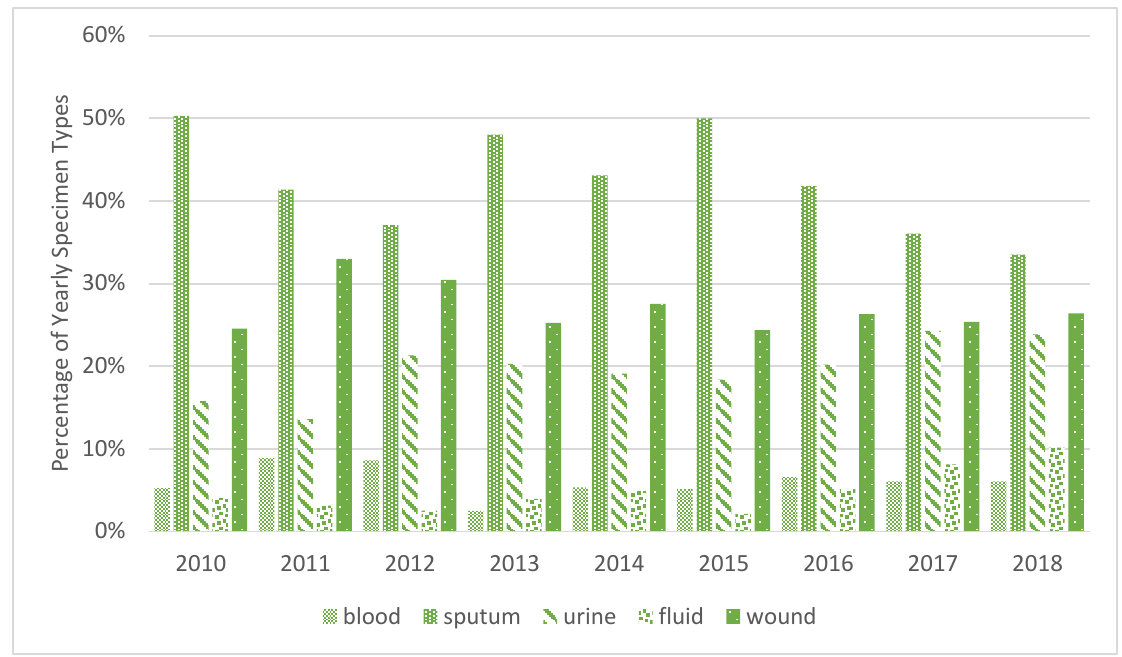
Figure 1. Yearly site distribution of Pseudomonas spp. isolates, in percentages.